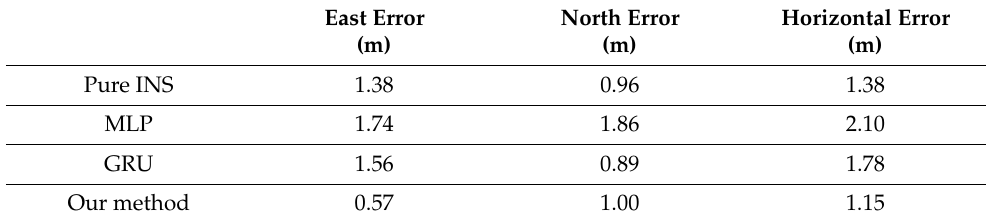
Figure 11. The trajectories of 60 s outage of Experiment 1. Table 2. Maximum position error of 60 s outage of Experiment 1.